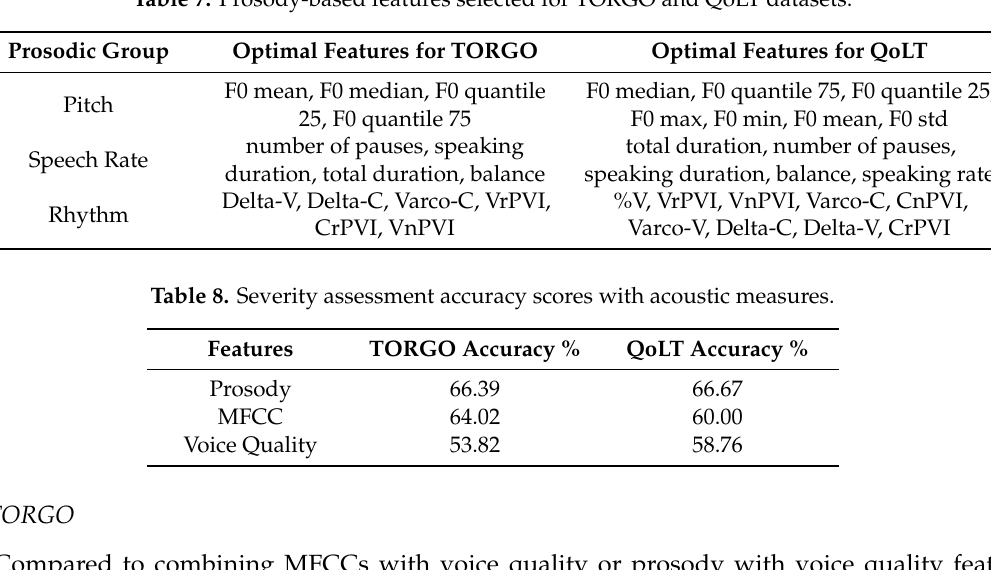
Table 7. Prosody-based features selected for TORGO and QoLT datasets.